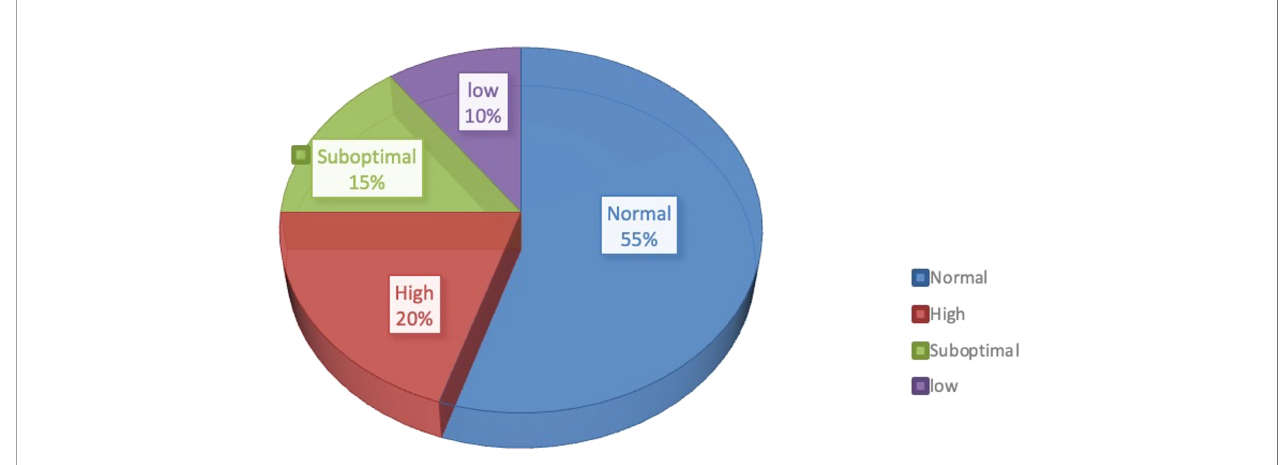
FIGURE 1 | Proportion of different ovarian responses during controlled ovarian responses types